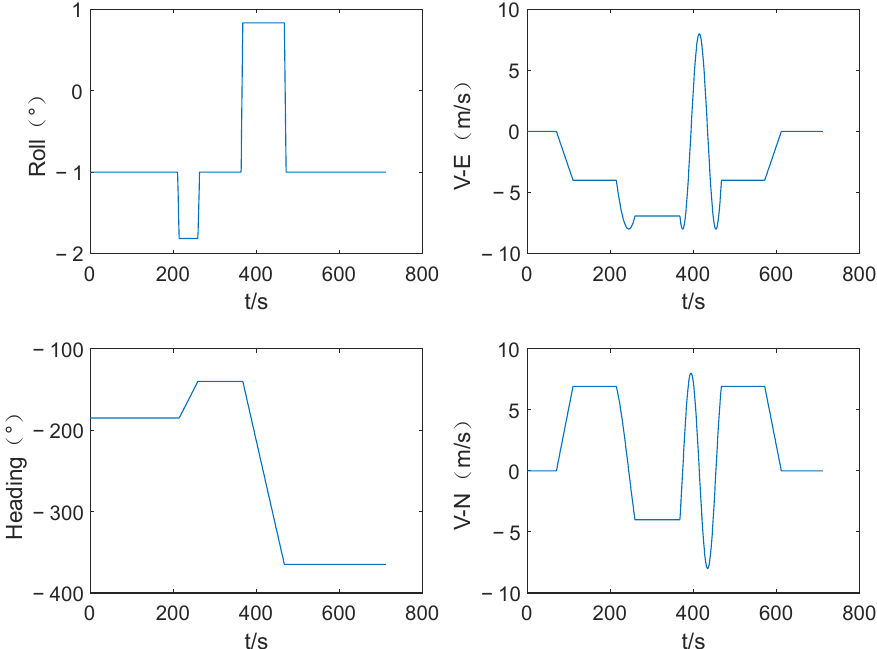
Figure 7. Simulated angle and velocity information.